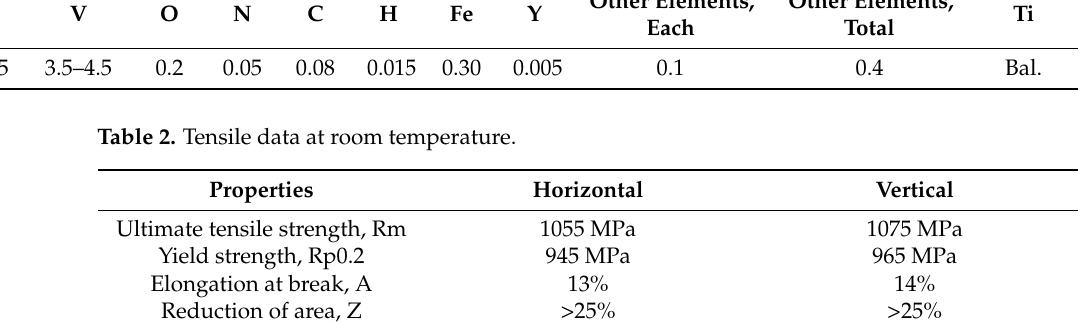
Table 2. Tensile data at room temperature.